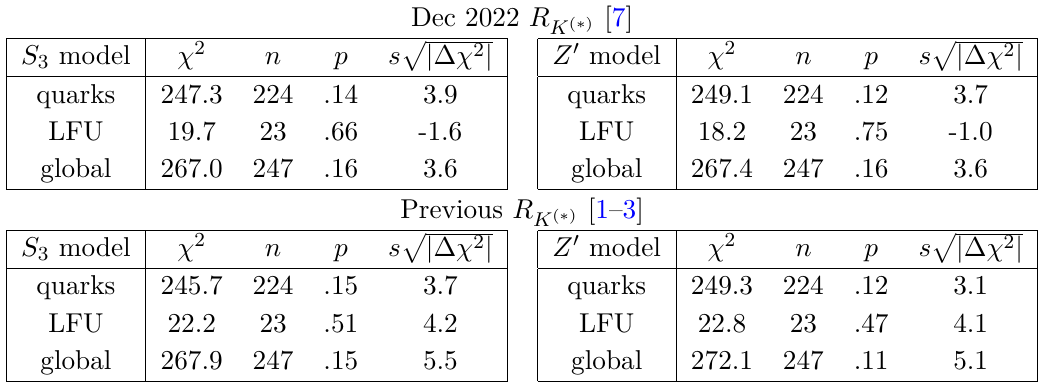
Table 5 . Quality-of-fit at the best-fit points of the S 3 leptoquark model and the B 3 − L 2 Z 0 model at M Z 0 = M S = 3 TeV. The first column displays the category of observable. n is the number of 3 measurements in each set. The χ 2 values for each best-fit point are also shown and ∆ χ 2 := χ 2 − χ 2 SM and s := sign (∆ χ 2 ) . The (updated- R ) best-fit parameters for the leptoquark model are λ = 1 . 3 , K ( ∗ ) θ 23 = − 0 . 000467 . For the Z 0 model, they are g Z 0 = 0 . 239 , θ 23 = − 0 . 0133 . Only the combined category includes the two fitting parameter reduction in the number of degrees of freedom when calculating p . The results using the R LHCb measurements [1–3] prior to December 2022 (but K ( ∗ ) including the BR ( B s → µ + µ − ) update in section 4.1) were performed separately and have